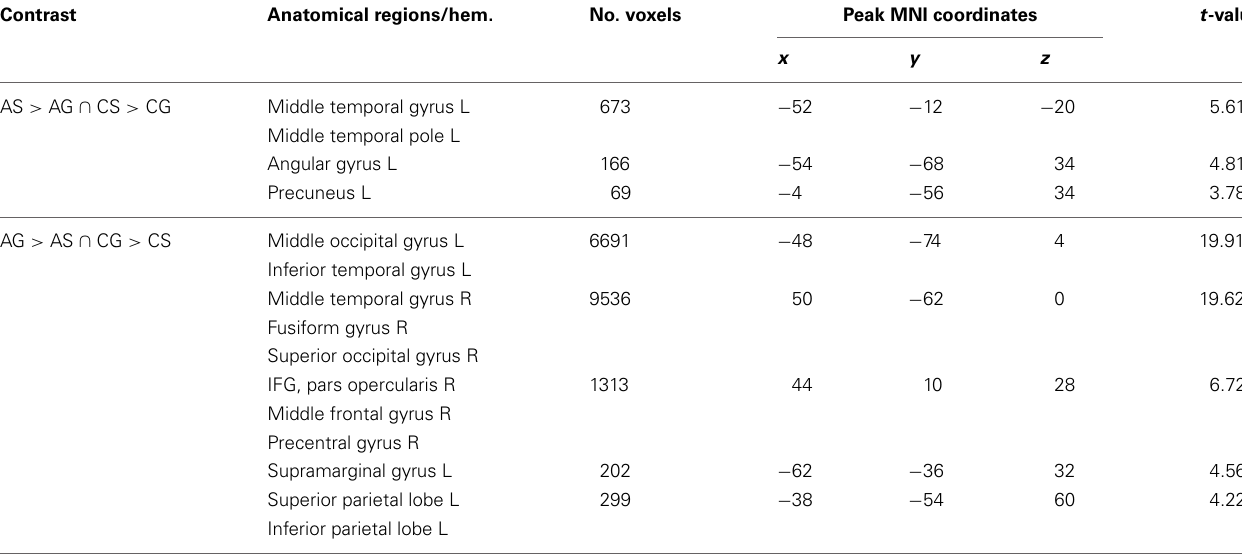
Table lists the respective contrast, anatomical regions, cluster size, MNI coordinates, and t-values for each significant activation (p < 0.05 corrected for